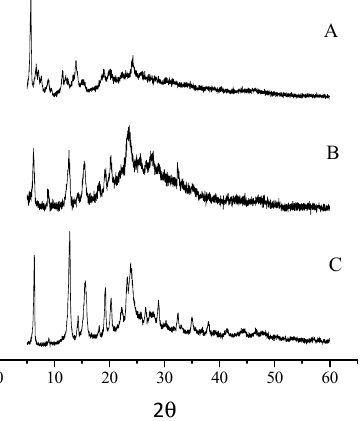
Figure 2. X-ray powder spectra of [Py 8 TPyzPzIn(OAc)]·8H 2 O ( A ), [Py 8 TPyzPzAlCl]·8H 2 O ( B ) and [Py 8 TPyzPzGaCl]·4H 2 O ( C ).